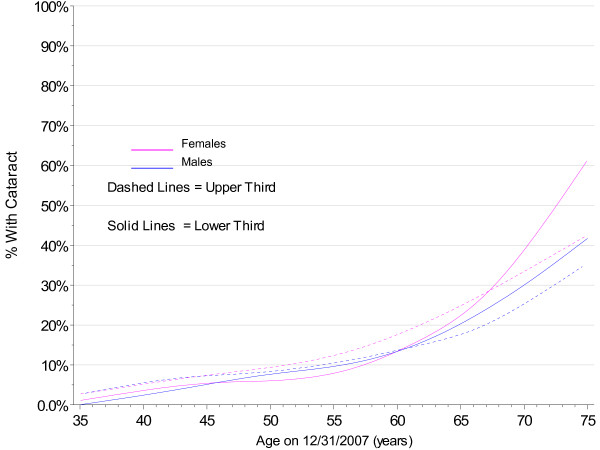
Smoothed 2007 Prevalence of Cataract by Gender and HDL (lower vs. upper third) Cohort with No Diabetes.